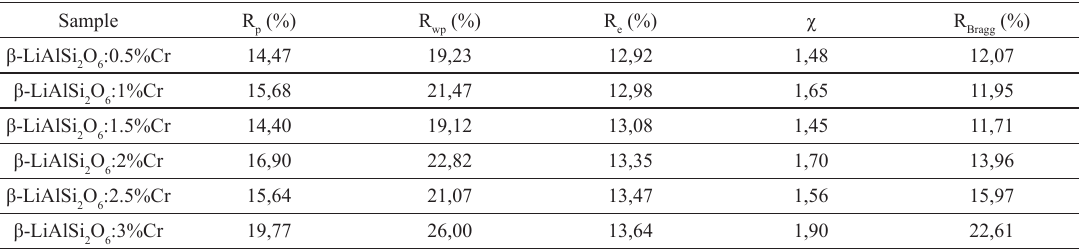
Table 1. Quality factors of the Rietveld refinement for β-LiAlSi